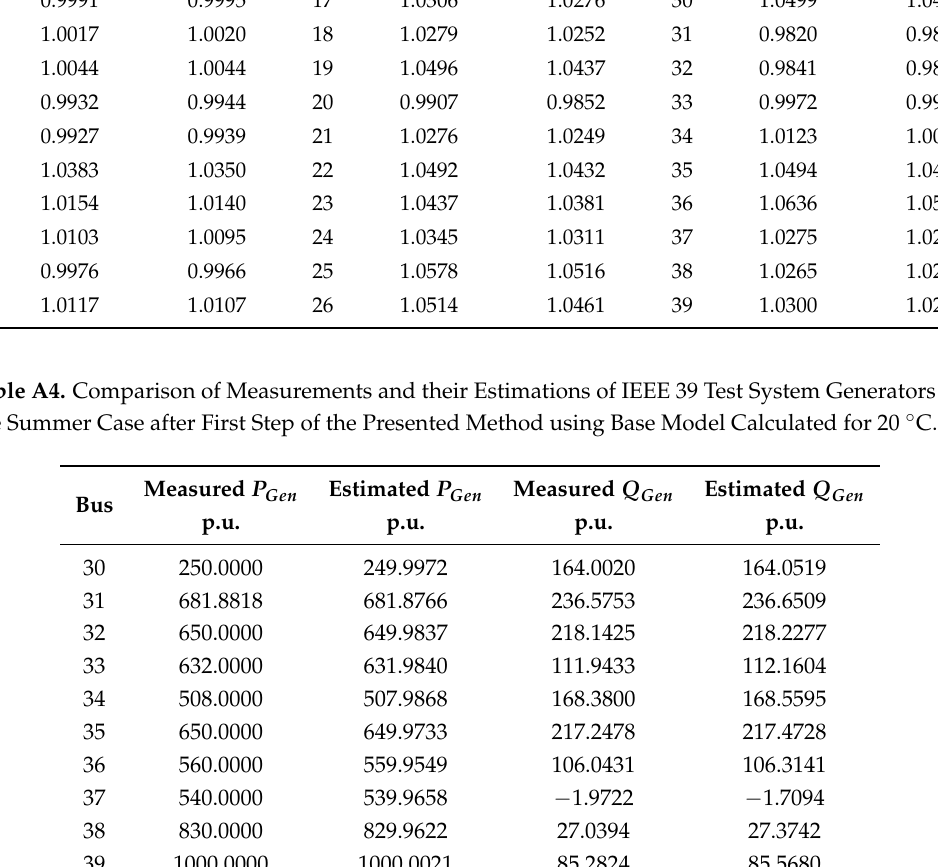
Table A5. Estimated Line Temperatures and Objective Function Values j of IEEE 39 Test System for Summer Case performed at the second stage of presented method.